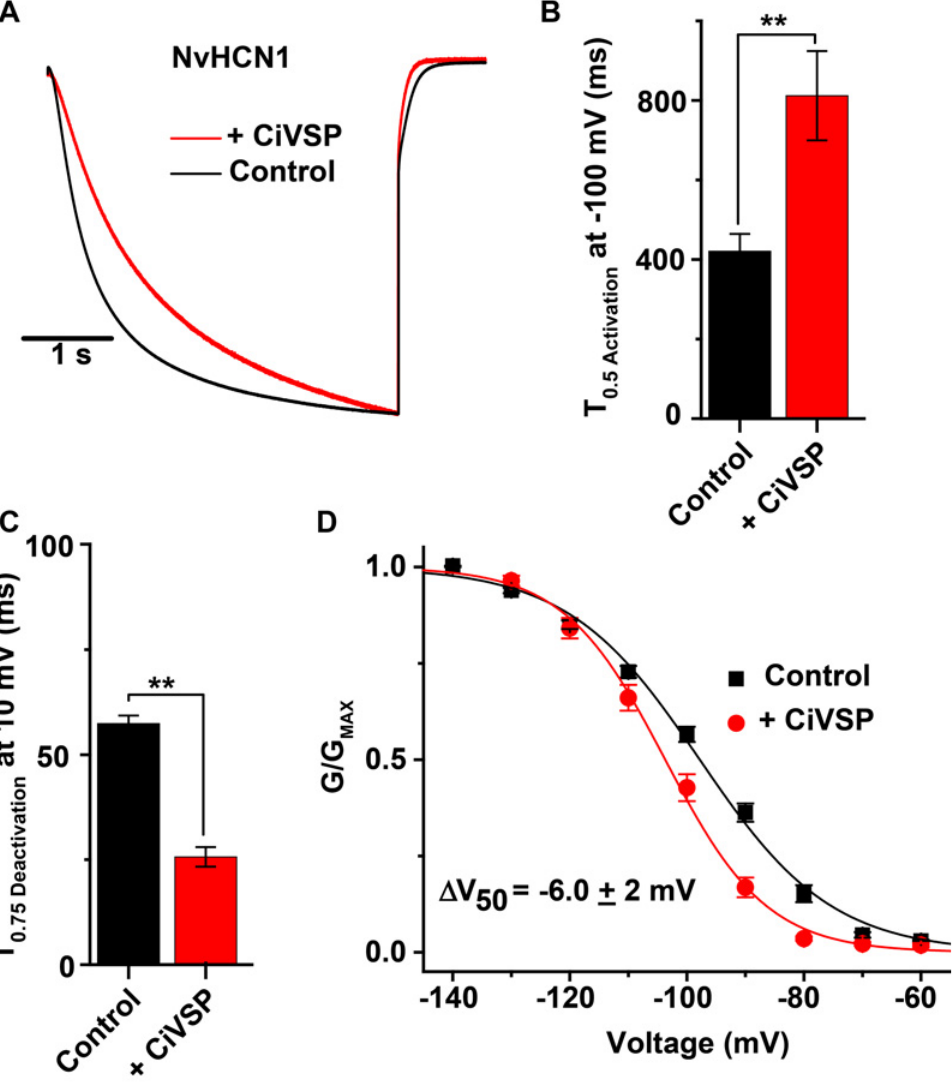
Fig 6. PIP 2 depletion inhibits activation of NvHCN1. (A) Normalized current traces recorded in response to a 4 s -100 mV voltage step for control (black) and with PIP 2 depletion by CiVSP (red). The holding voltage was -30 mV and tails were recorded at -50 mV. CiVSP was activated with a 2 s step to + 60 mV 400 ms prior to the hyperpolarizing current step. (B) Half activation time at -100 mV for NvHCN1 control (black) and for CiVSP-dependent PIP 2 depletion (red). (C) 75% deactivation time at +10 mV for NvHCN1 controls (black) and for PIP 2 depletion (red). (D) GV curves for NvHCN1 controls and NvHCN1 + CiVSP-dependent PIP 2 depletion. All data show mean ± S.E.M.; ** in B and C indicates significant difference (p < 0.01, t-test, n = 7 – 9). Smooth curves in D show single Boltzmann fits of the data; fit parameters and sample numbers are reported in Table